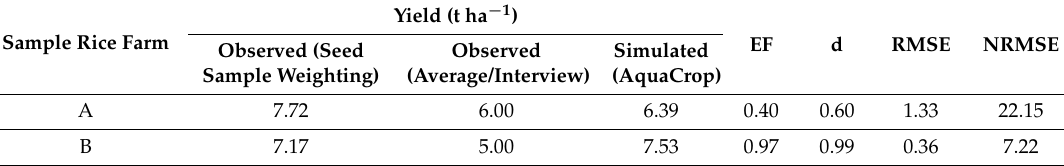
Table 7. Statistical Results of Yields Simulated from the Calibrated Crop Parameters of the Training Points.